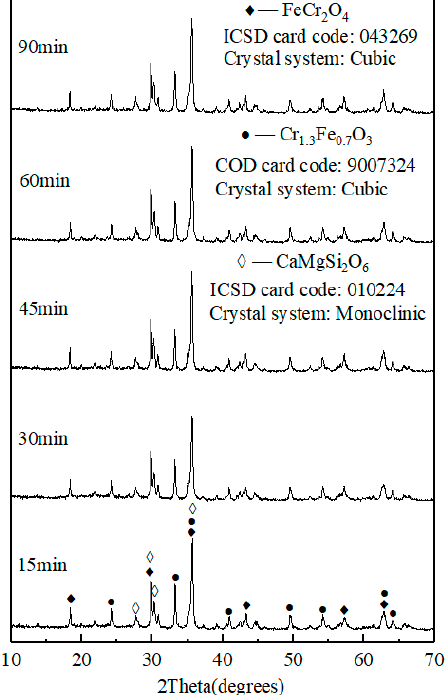
Figure 11. XRD patterns of ceramic tiles with Fe/Cr = 2.0 sintered at 1150 °C for different time.